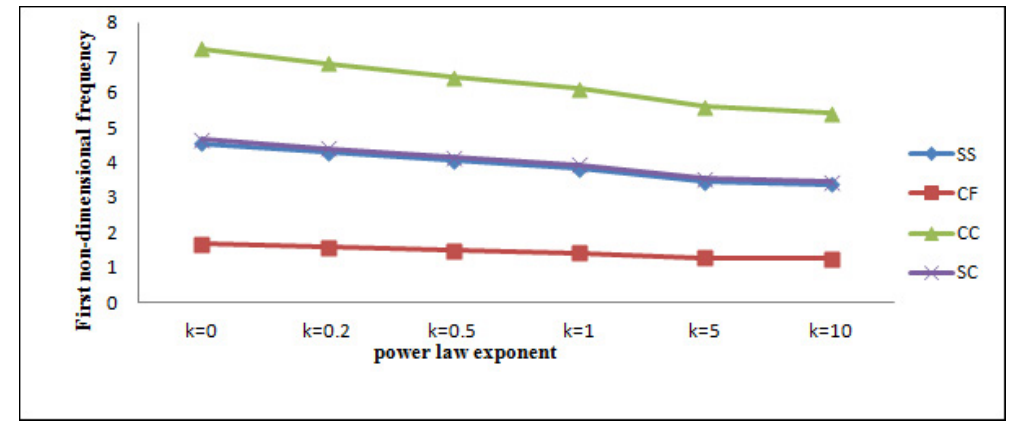
Figure 8: variation of first non- dimensional frequency with different boundary conditions Table 5: First non-dimensional frequency (λ) for different boundary conditions